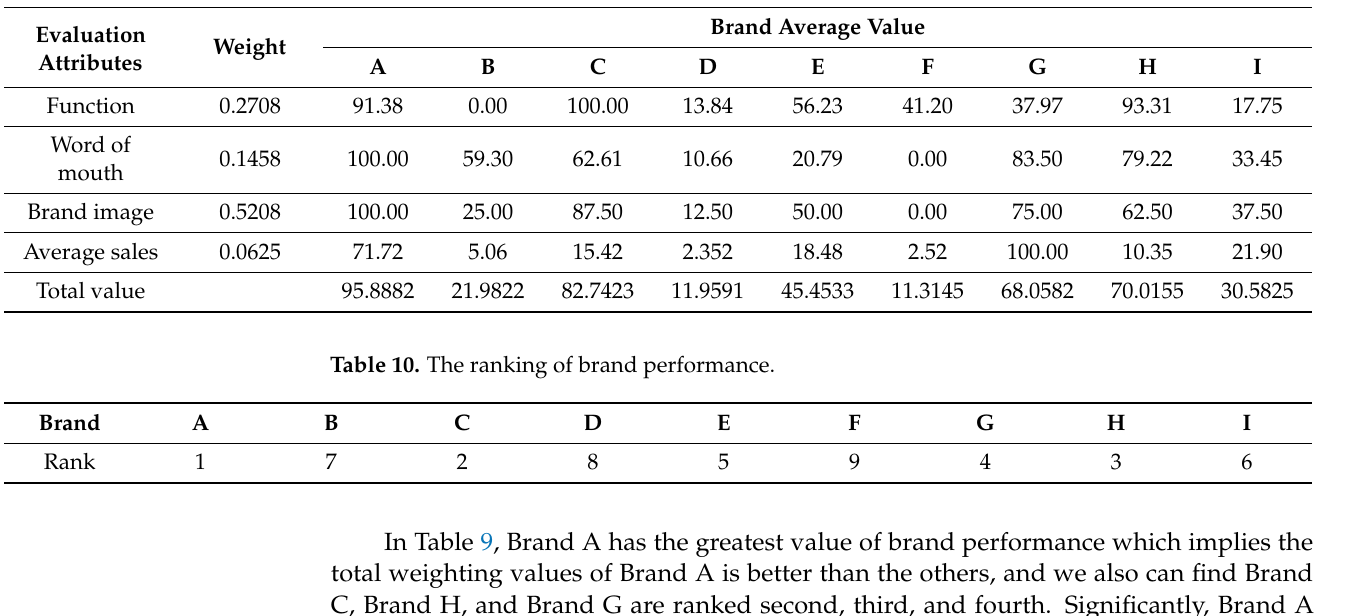
Table 9. The result by SMART–ROC analysis.